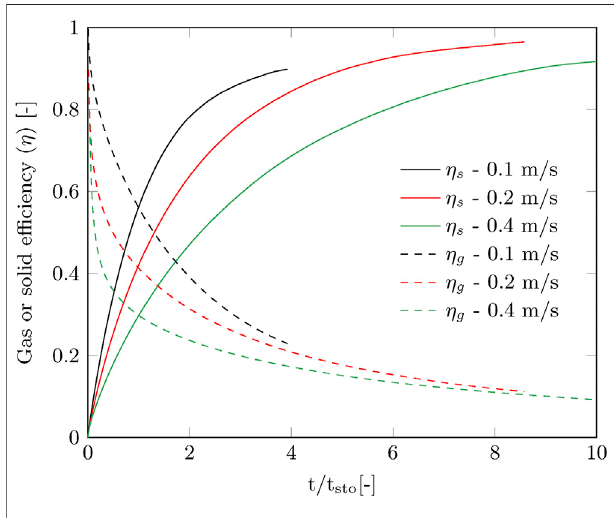
FIGURE 3 | Breakthrough curves of the batch experiments for various super fi cial gas velocities. The equilibrium capacity at direct air capture conditions under the prevailing lab conditions is indicated as well.